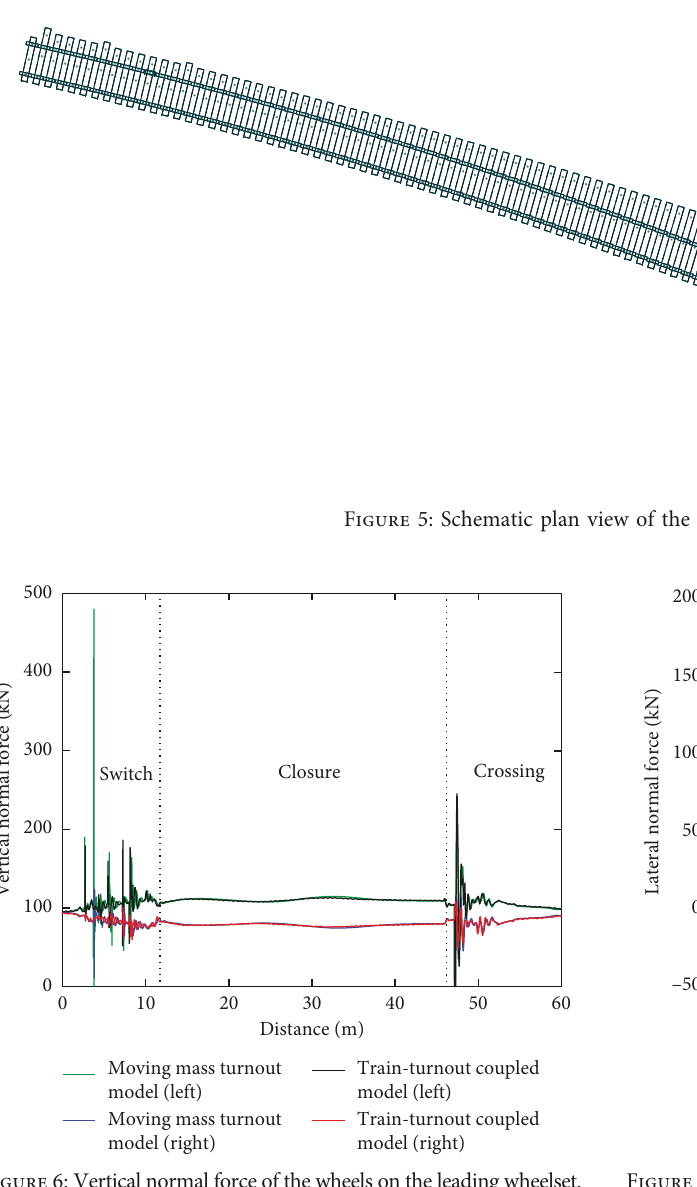
Figure 6: Vertical normal force of the wheels on the leading wheelset. Figure 7: Lateral normal force of the wheels on the leading